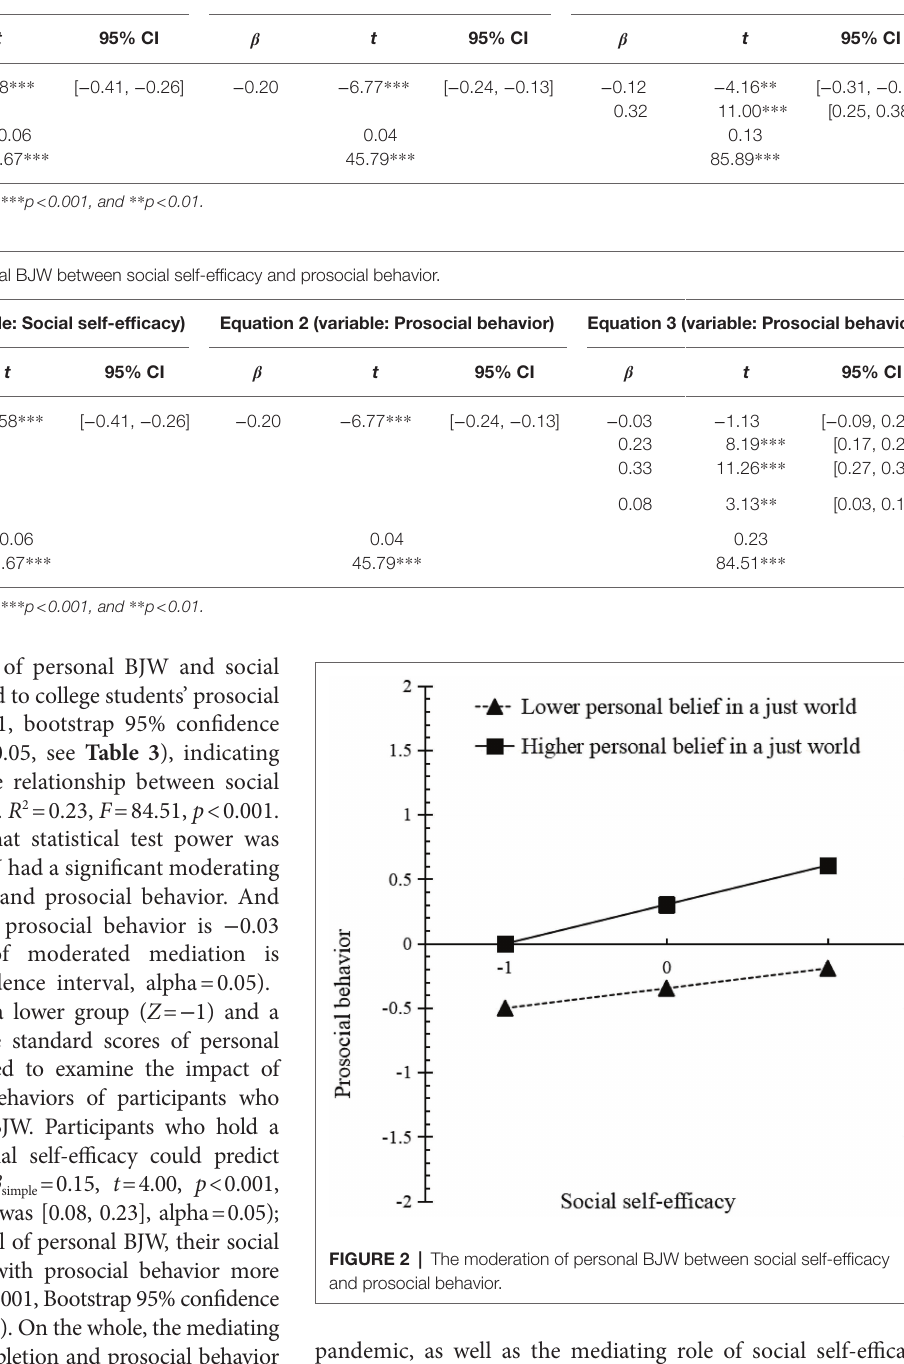
TABLE 2 | The mediating effect of social self-efficacy between ego depletion and prosocial behavior. Equation 1 (variable: Social self-efficacy) Predictors